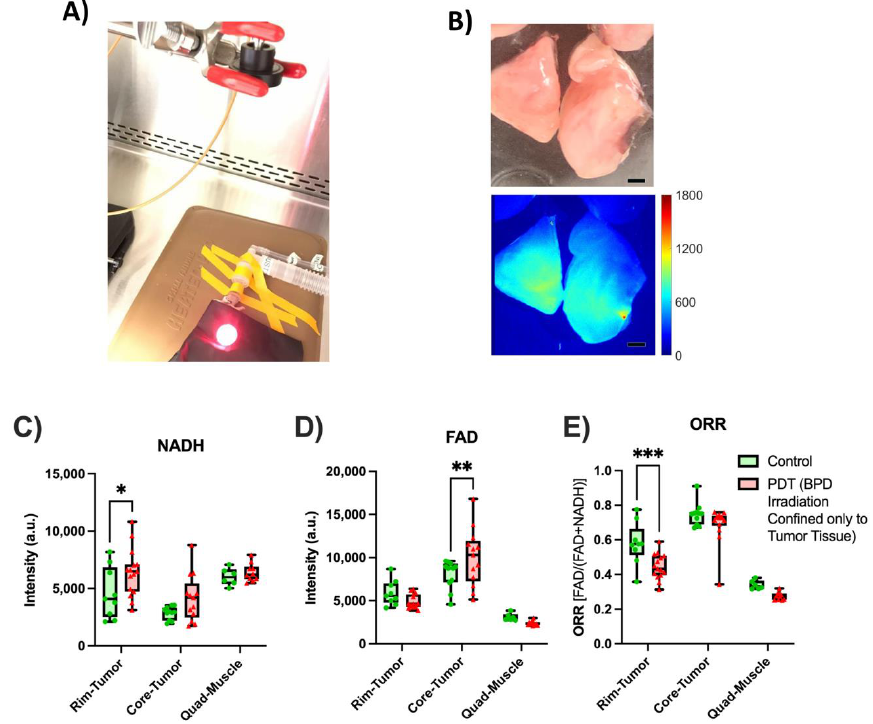
Figure 8. PDT treatment of malignant mouse tumor and subsequent endoscopic imaging. ( A ) An MDA-MB-231 tumor being exposed to the activation laser light after being injected with BPD: ( B ) A color image of a subdivided tumor (upper) and the BPD fluorescence (lower) in the tumor, with the color bar representing the concentration of BPD in nM. The black scale bar is equal to 1.5 mm: ( C )